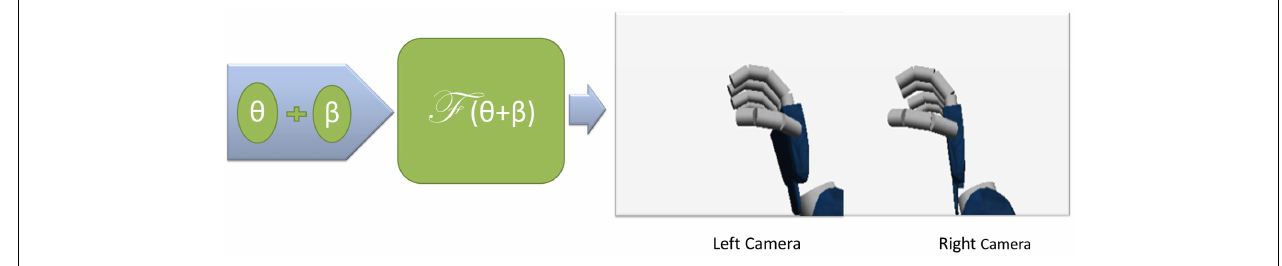
FIGURE 3 | Image generation in the internal mental simulator . The observation is defined as the concatenation of the left and right cameras.